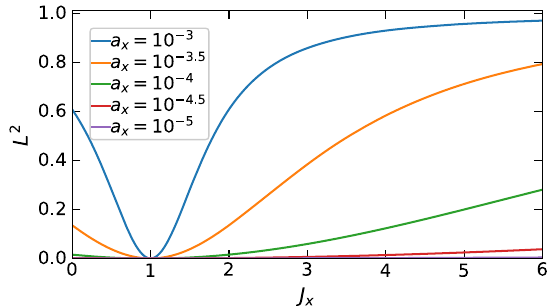
FIG. 2. Action dependence of L 2 for a horizontal damper gain 0 . 01 and different values for the octupole detuning coef- g x ¼ ficient a , in the simplified case that b x